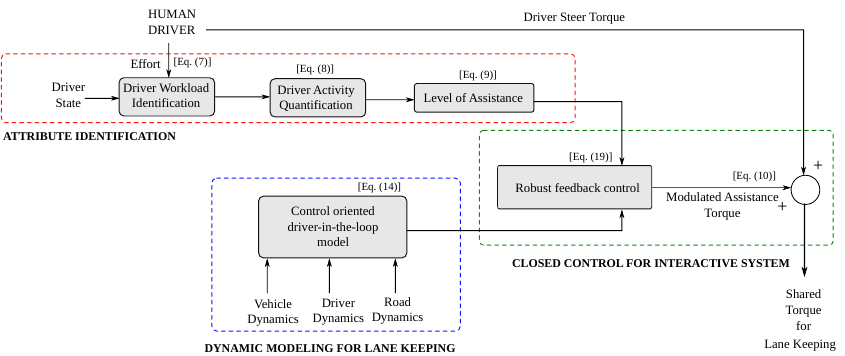
Figure 3. Flow chart of the